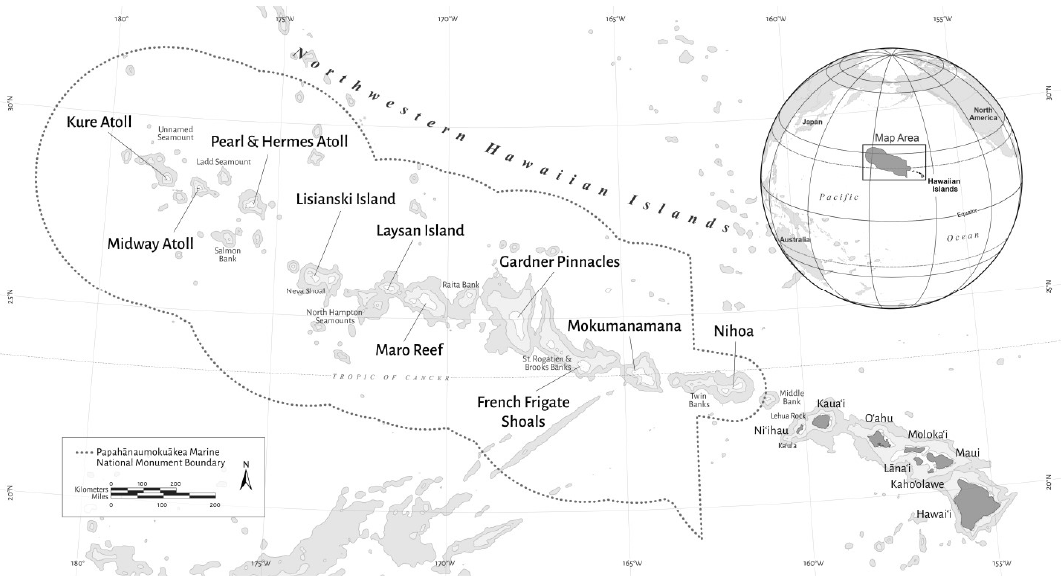
Figure 1. Map of the Hawaiian Archipelago, including the Northwestern Hawaiian Islands (NWHI).